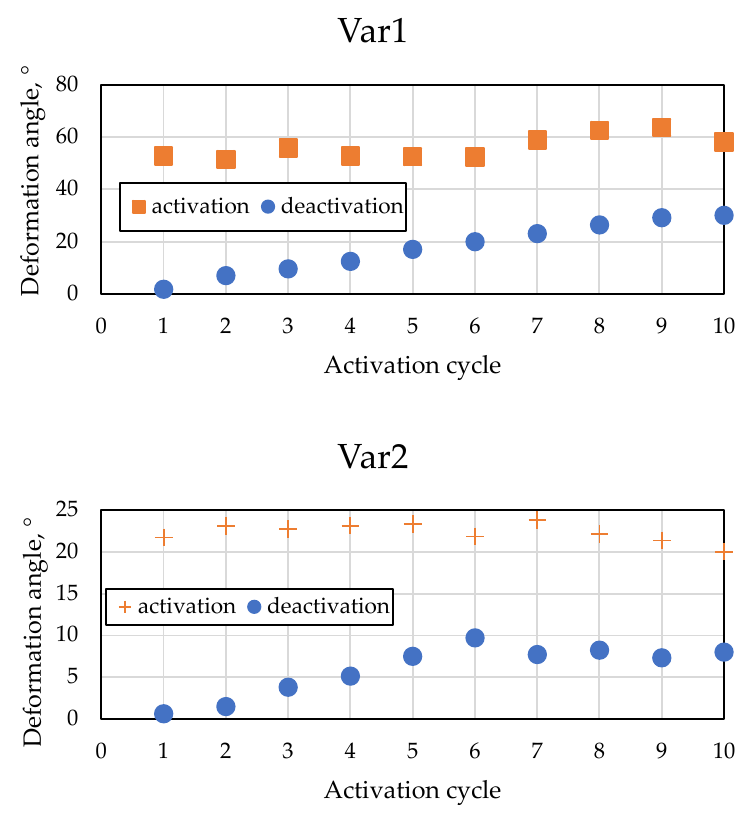
Figure 15. Activation test results of the IFRC specimens Var1 and Var2. Due to the overall irregular deformation shape of the specimens, their uneven sur- face, and the local curling at the free ends, evaluating the deformation angle from the measurement results was challenging. Therefore, the estimated deformation angles can only serve as a rough estimation of the real deformation behavior that was achieved. How- ever, several effects can be observed: